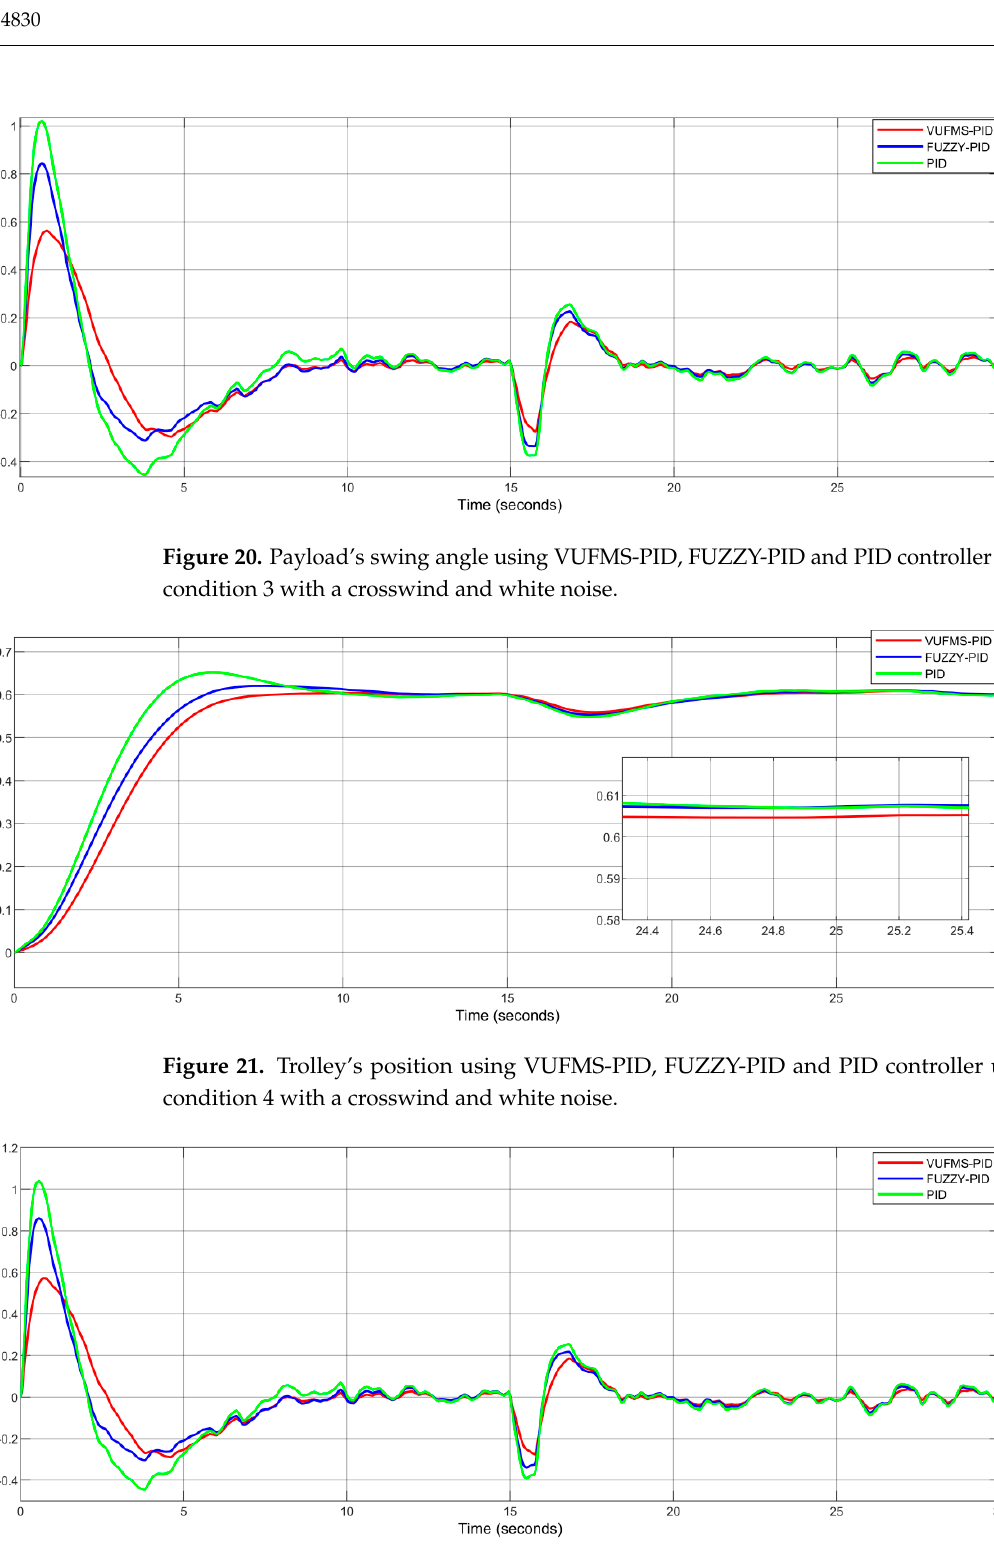
Figure 22. Payload’s swing angle using VUFMS-PID, FUZZY-PID and PID controller under working condition 4 with a crosswind and white noise.